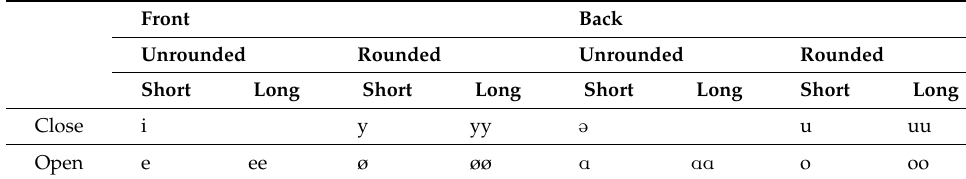
Table 2. The vowels of Kirghiz.